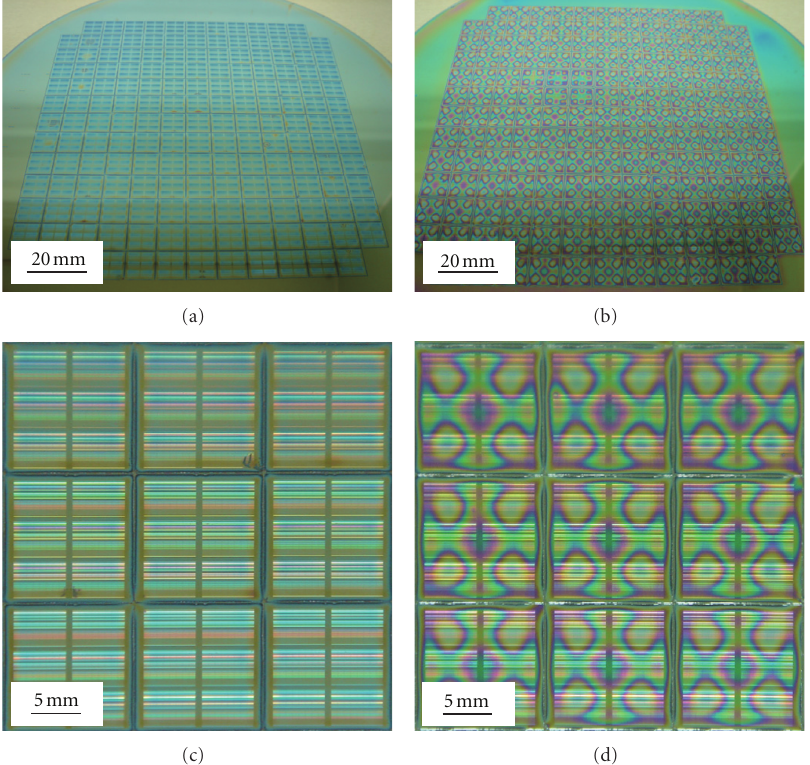
Figure 7: Fabrication of 165 dies on a silicon substrate by step-and-repeat UV nanoimprinting under atmospheric pressure: (a) fabrication of 165 dies using high-viscosity resin (entire area), (b) fabrication of 165 dies using low-viscosity resin (entire area), (c) fabrication of 165 dies using high-viscosity resin, and (d) fabrication of 165 dies using low viscosity